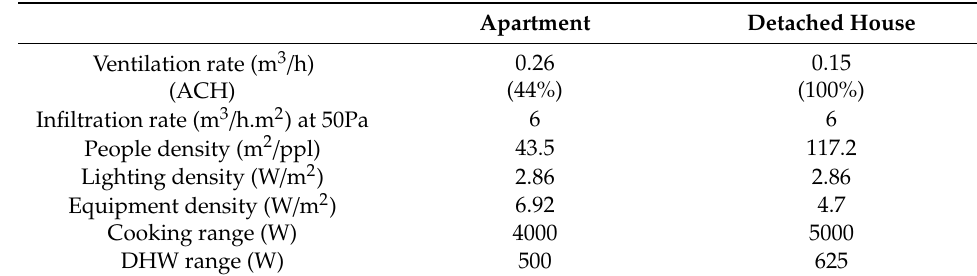
Table 2. Internal loads of the prototypical buildings.